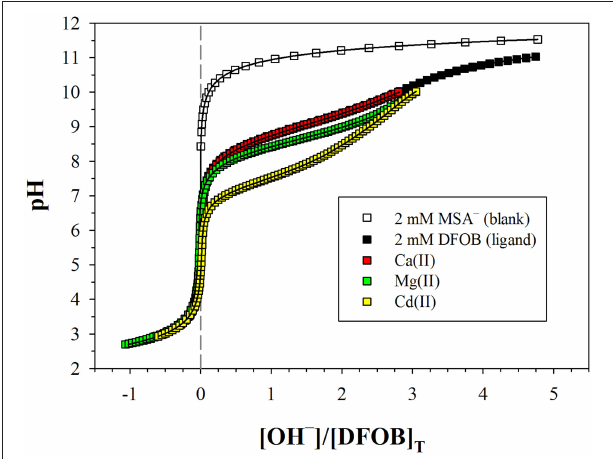
FIGURE 2 | Potentiometric titrations of a DFOB solution and metal + DFOB mixtures in 0.7M NaClO 4 , where pH is plotted against moles of base (OH − ) added per mole of DFOB. The blank contains 2 mM mesylate (MSA − ), which is fully deprotonated over the entire pH range. All other solutions contain 2 mM DFOB mesylate. Symbols are measurements. Solid lines are non-linear regressions performed with FITEQL4.0. The more a metal + DFOB titration deviates from that of DFOB alone, the higher the stability of the metal–DFOB complexes formed. Note that the DFOB and Ca + DFOB titrations are almost indistinguishable. Cadmium (Cd), which forms the weakest hexadentate complex among the divalent transition metals ( Schijf et al., 2015), is shown for comparison. The M:L ratio is about 1:1 for Mg and Ca, and about 0.7:1 for